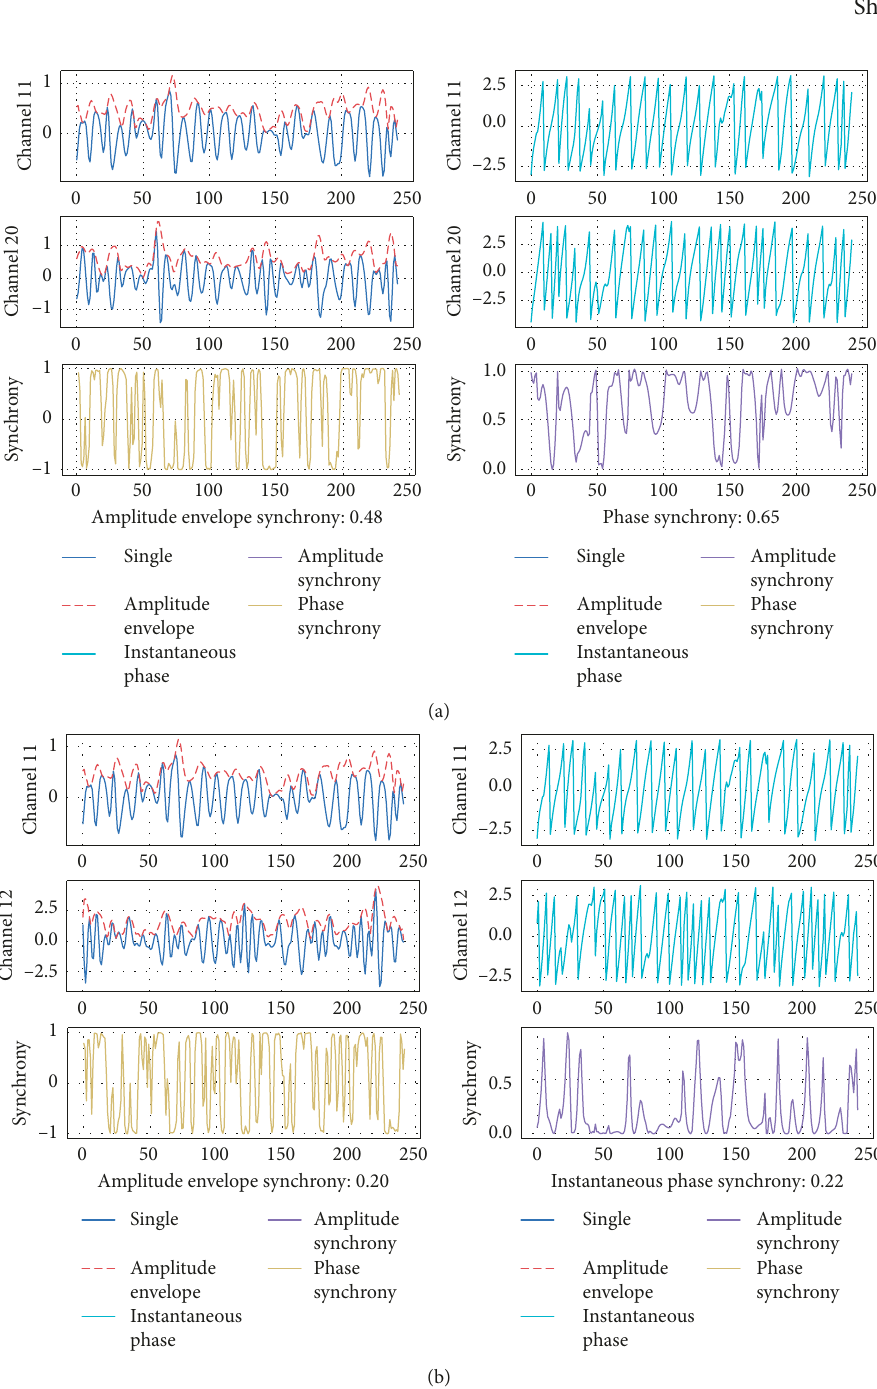
Figure 6: Synchrony analysis based on instantaneous phase and amplitude envelope. (a) The lateral acceleration of the bogie 1 in the middle (channel 11) and the lateral acceleration of the axle box 1 (channel 20). (b) The lateral acceleration (channel 11) and the vertical acceleration (channel 12) of the bogie 1 in the